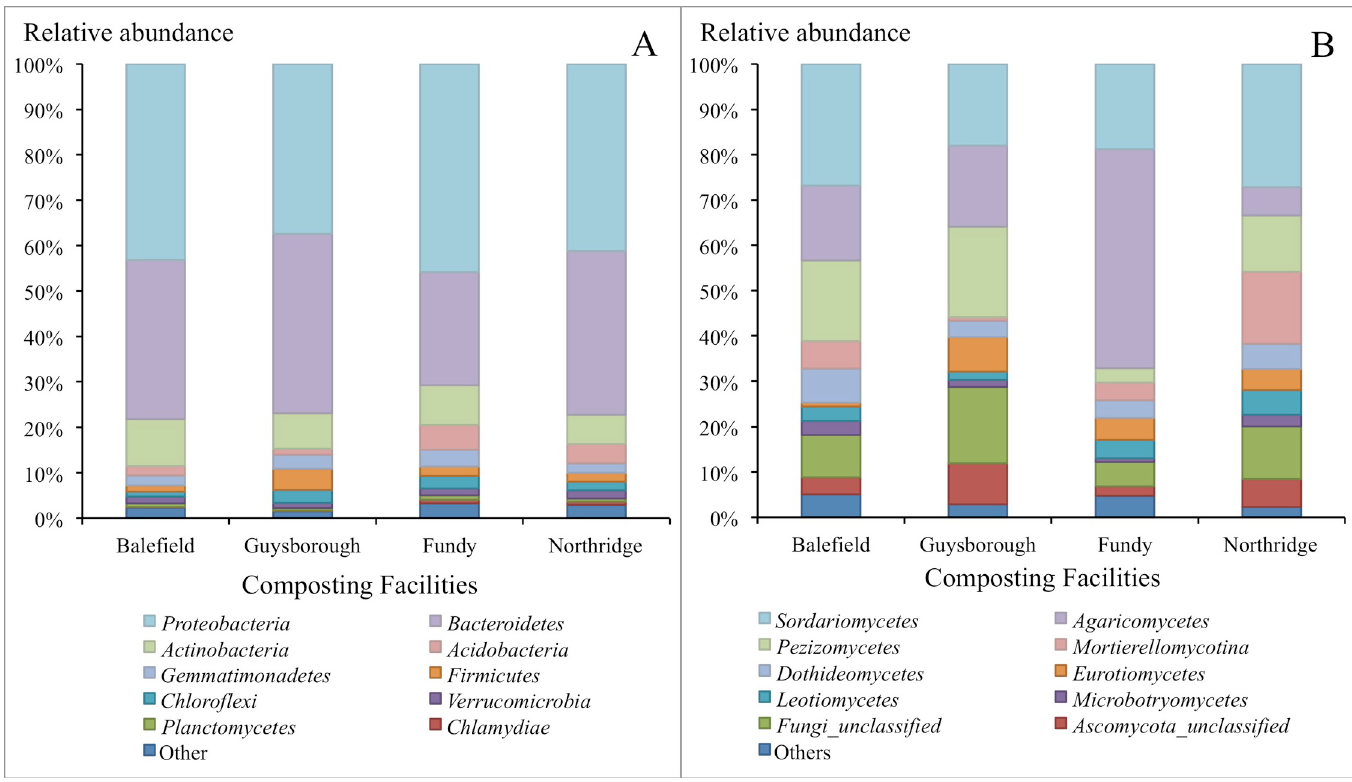
Fig 1. Relative abundances of microbial taxa present in the microbial communities from different composting facilities. Each bar represents microbial communities from both mature bulk and PA compost. (A)–Bacteria, 16S rRNA gene; and (B)–fungi, ITS.